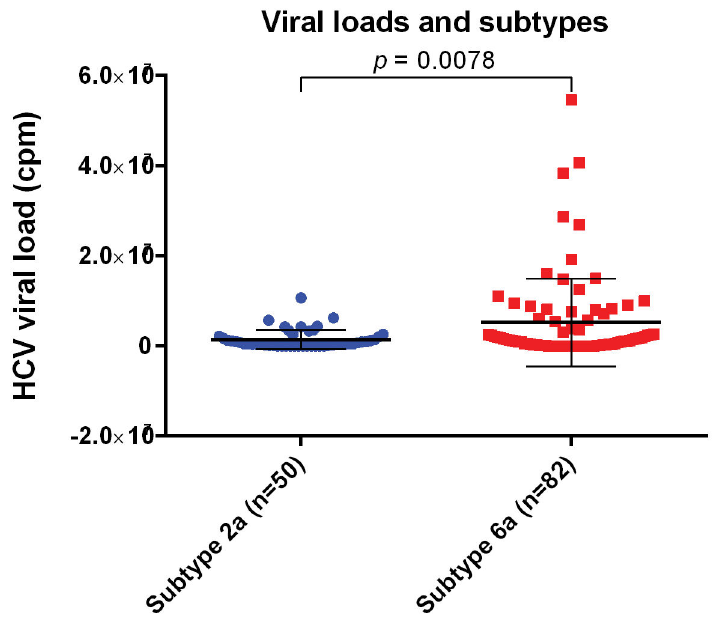
Figure 5. HCV viral loads and subtypes. Plasma viral loads of 50 HCV 2a cluster cases and 82 HCV 6a cluster cases were compared. Statistical analysis was performed by two-tailed p value in GraphPad, unpaired t test result p < 0.01 was considered